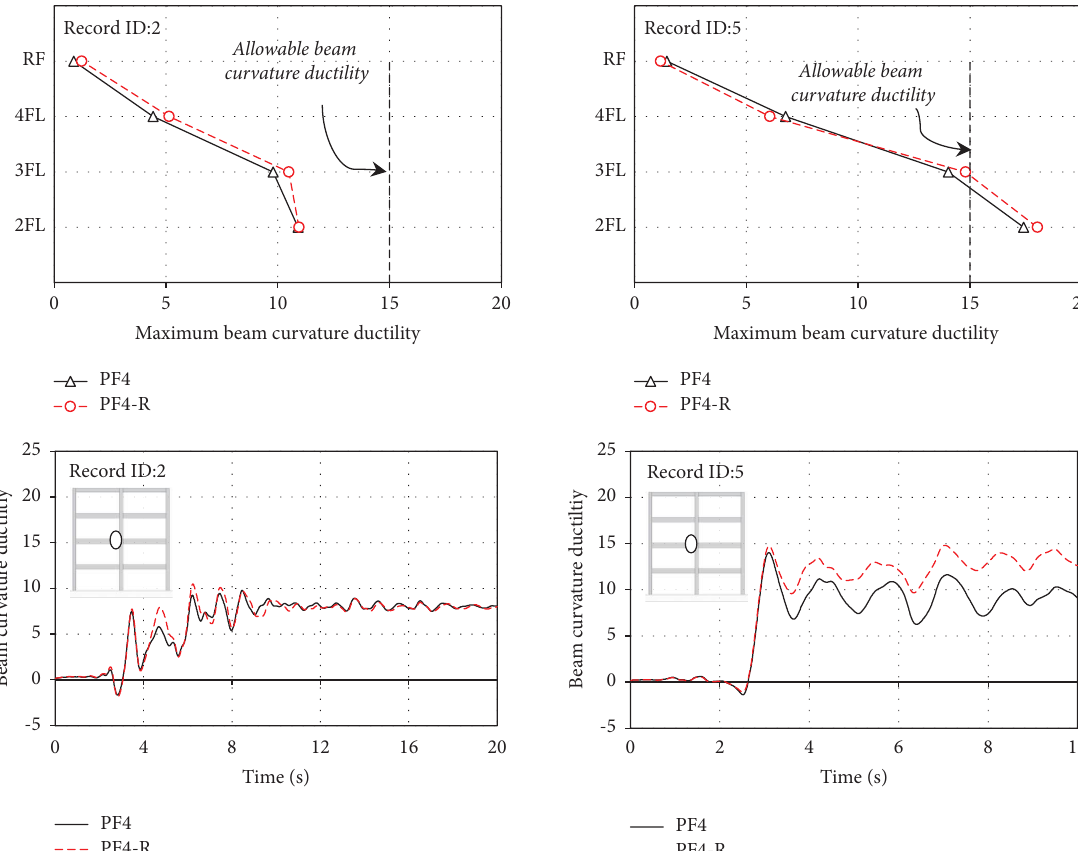
Figure 16: Maximum curvature ductility demands placed upon the beams of the four-story frames subjected to Kobe and Northridge earthquake ground